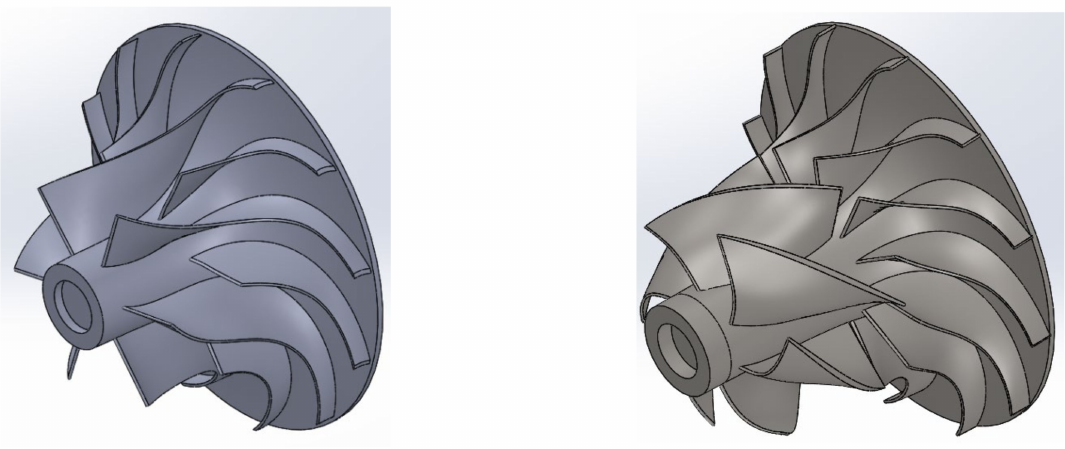
Figure 8. The original GT 12 impeller ( left ) and the new tandem geometry ( right